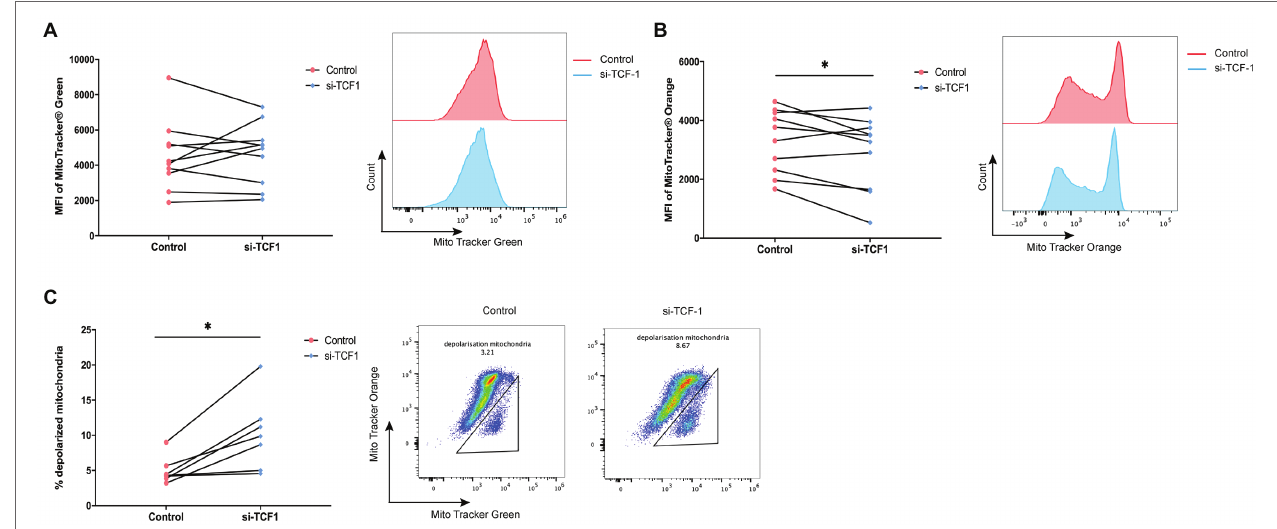
FIGURE 5 | T cell factor (TCF)1 knockdown impairs mitochondrial function. After knockdown with siTCF1 for 24 h, (A) mitochondrial mass was analyzed in primary CD3 + T cells ( n = 10) labeled with Mito Tracker Green and (B) mitochondrial membrane potential was analyzed in primary CD3 + T cells ( n = 10) labeled with Mito Tracker Red. (C) The percentage of depolarized mitochondria (defined by low mitochondrial membrane potential and high mitochondrial mass [MMP lo /MM hi ]) in TCF1 knockdown T cells ( n = 7) was increased which were labeled with Mito Tracker Green and Mito Tracker Orange. Paired t -tests were used in (A - C) . * p <